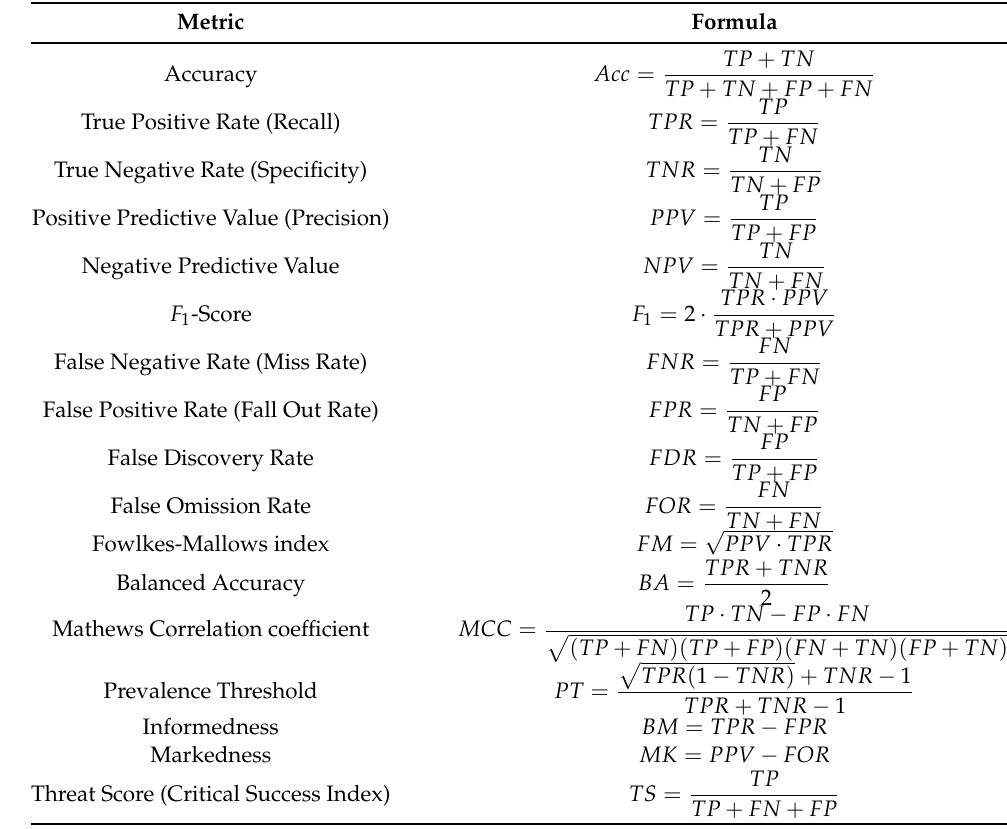
Table 2. The performance metrics of the binary classification confusion matrix.